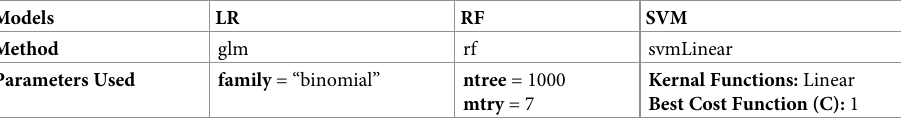
Table 2. Hyperparameters used in ML models